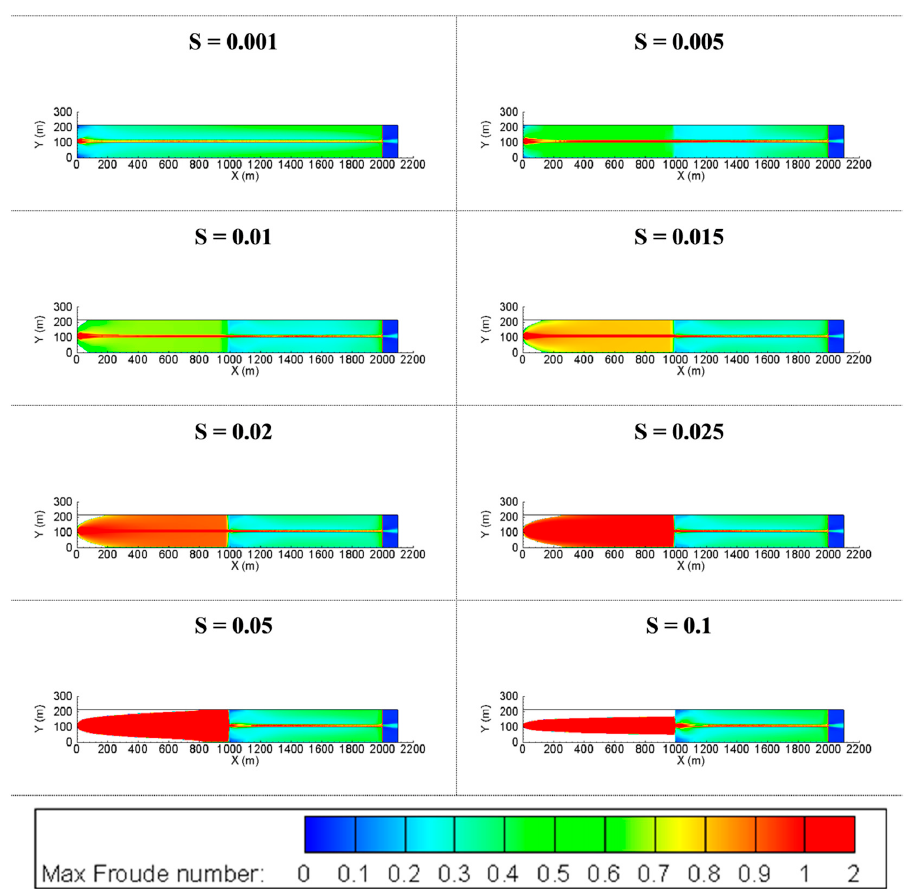
Figure 4. Predicted maximum Froude numbers for different variations of the idealised valley test case.